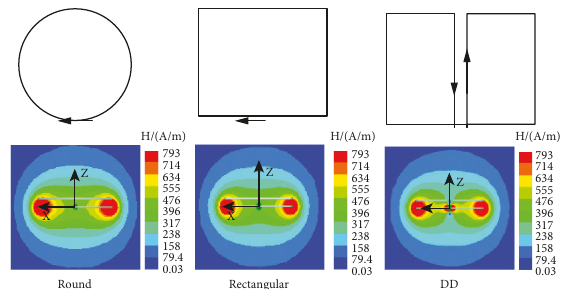
Figure 1: Magnetic field intensity distribution of different coil structures in the XZ